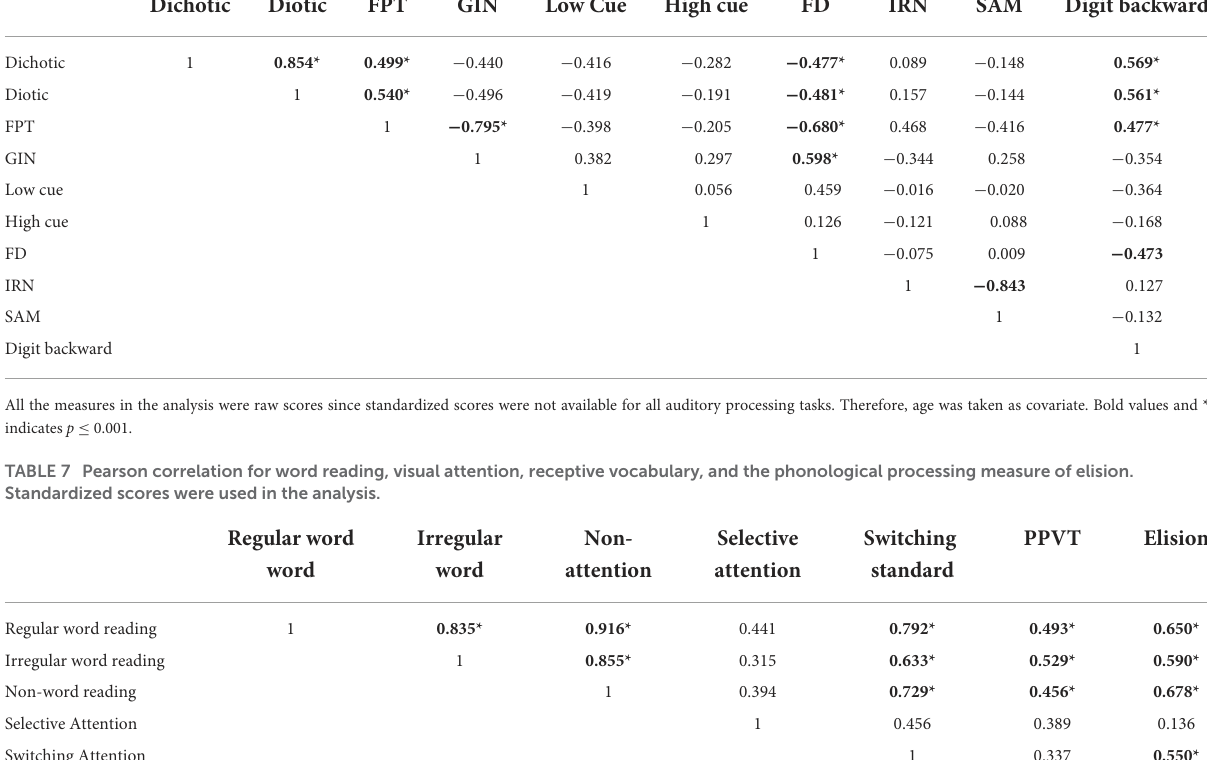
Irregular word reading 1 Non-word